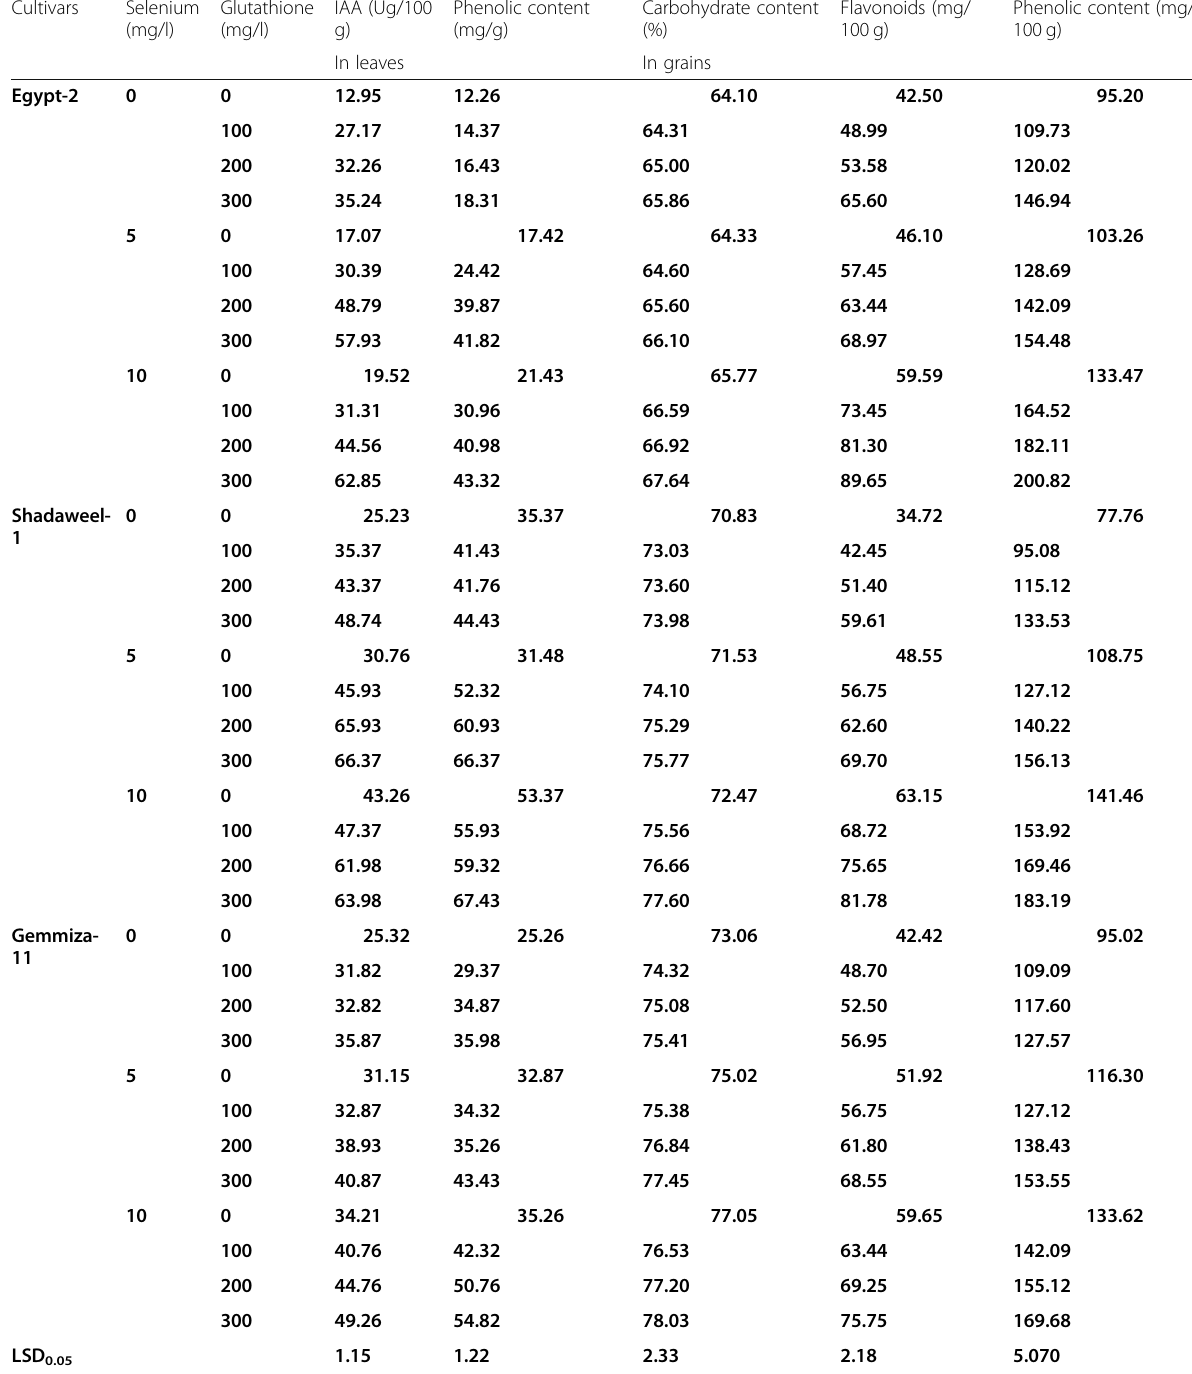
Table 4 Effect of glutathione and/or selenium on some biochemical constituents of three wheat cultivars grown under conditions of the Nubaria region